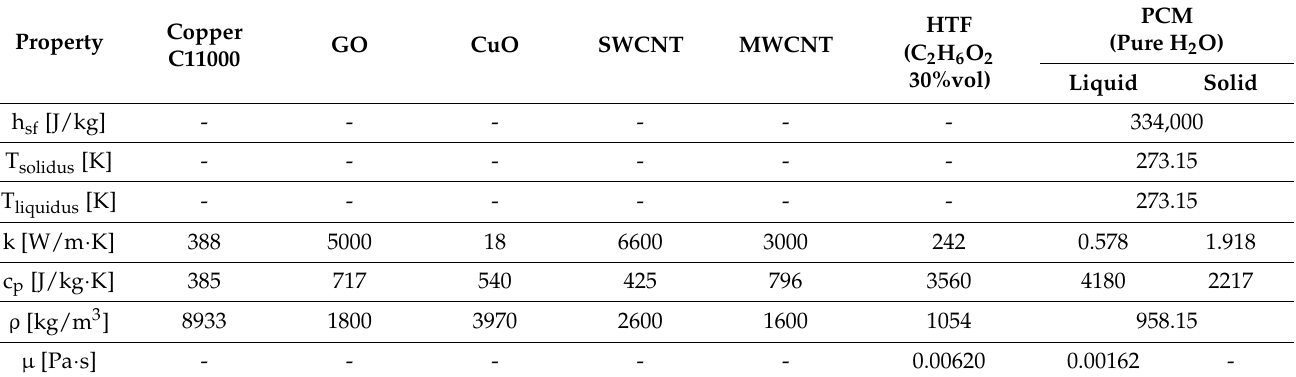
Table 1. The required thermophysical data